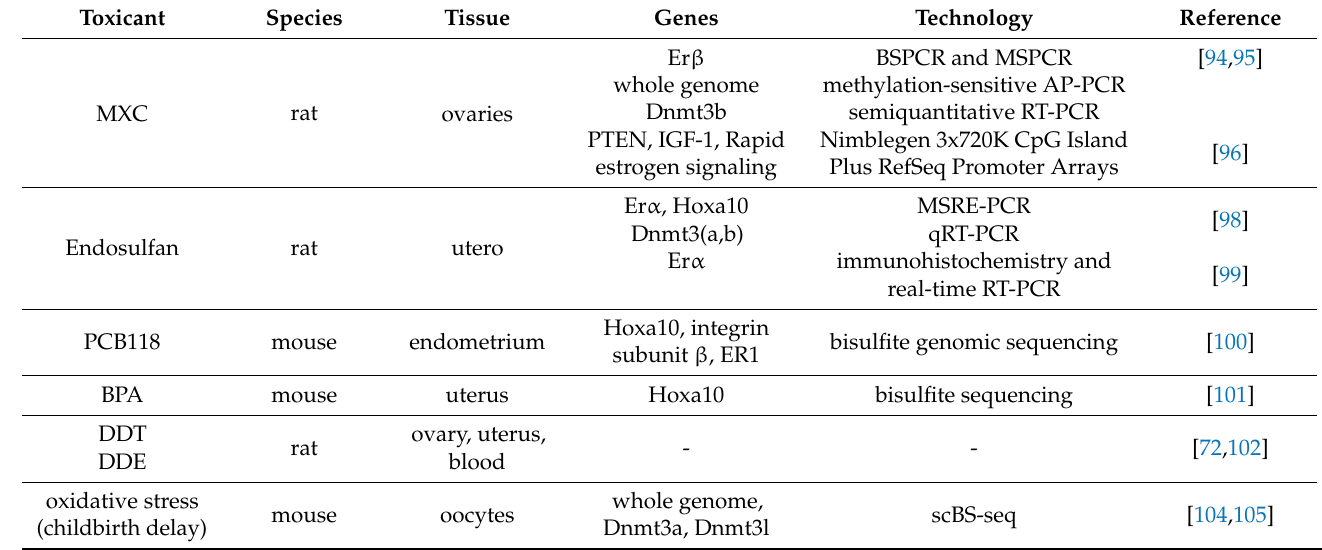
Table 2. Summary of studies on the impact of different toxic substances on female reproductive fitness through DNA